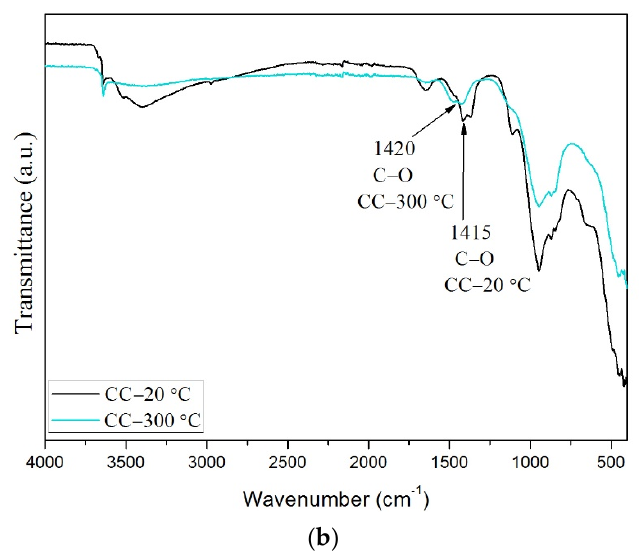
Figure 5. ( a ) FTIR spectra of specimens exposed to 20, 300, 550 and 900 °C. ( b ) Comparison of CC curves at 20 °C and 300 °C.